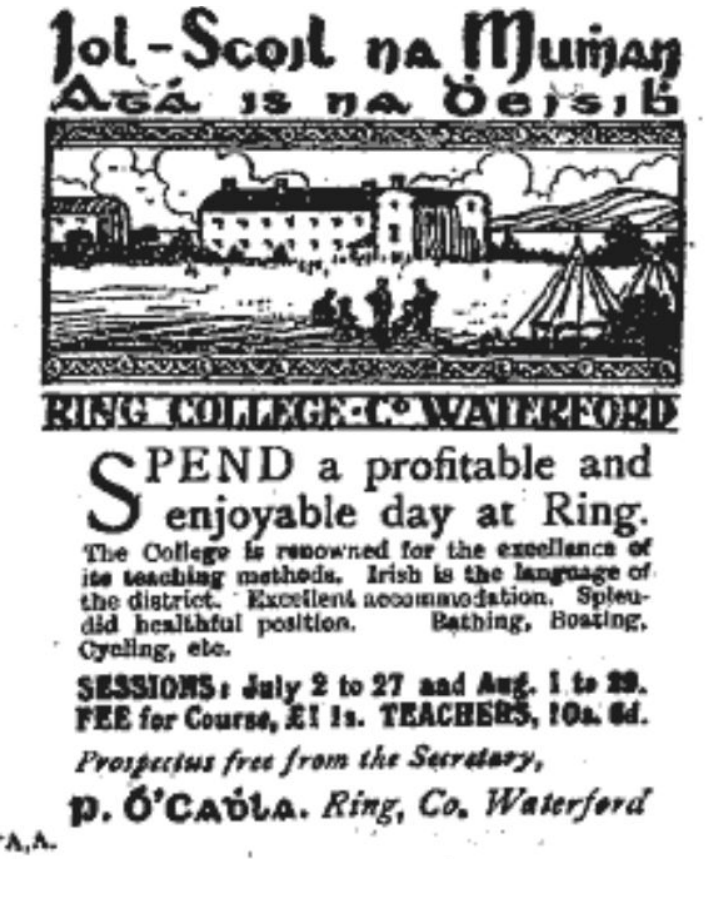
Fig. 2 Advertisement for a school of Irish Language based in County Waterford. From Young Ireland , 1.9 (16 June 1917), 3. Image Courtesy of the